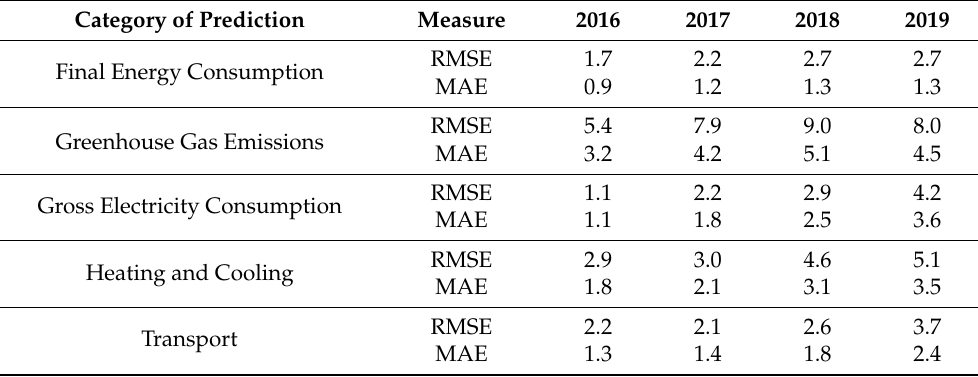
Table 1. Root mean square error and mean absolute error estimated for the OpEnergy model for five significant energy-intensive categories (EU-27,